Question: Name the type of graph shown.
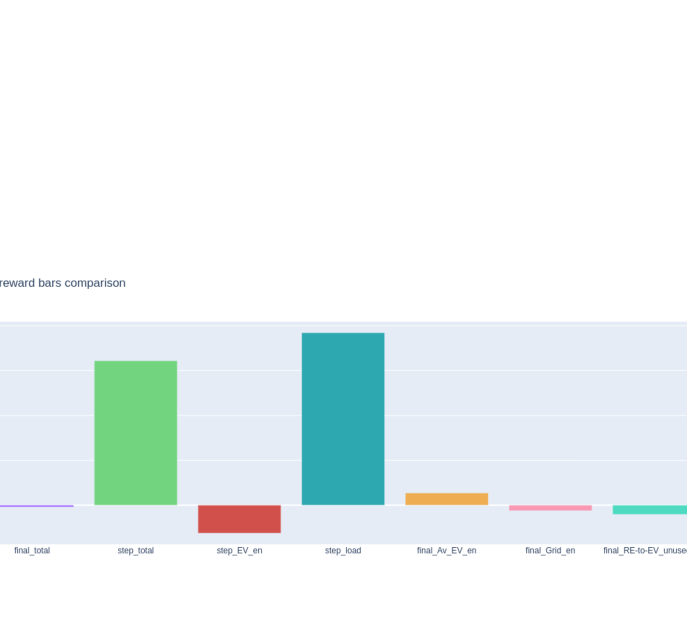
Answer: line